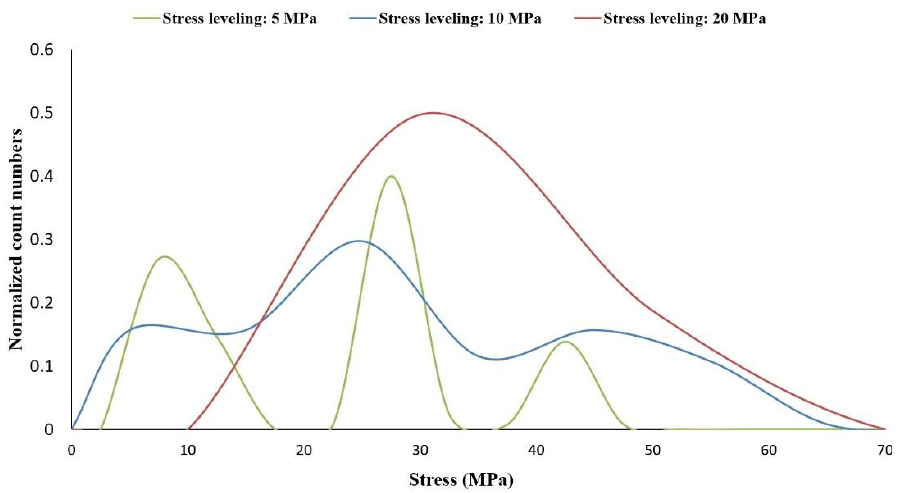
Figure 13. Probabilistic distribution of von Mises equivalent stress on the critical element due to small temperature variations.